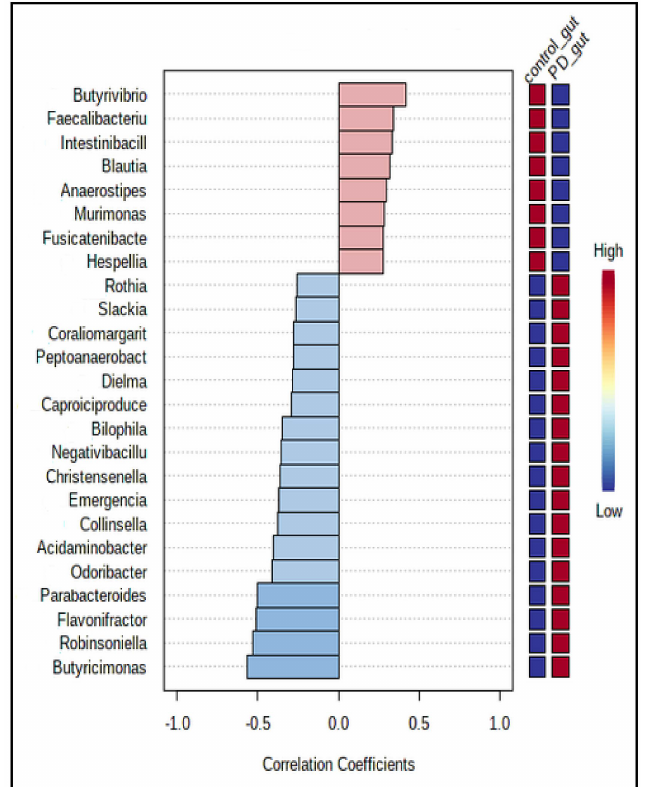
Figure 5. The Pearson r correlation, showing the top 25 features correlated with the taxa of interest. The 25 genera were ranked by their correlation. The blue color represents negative correlations, whereas the red color represents positive correlations. The deeper color (blue or red) means, the stronger correlation. The mini heatmap on the right side of the plot shows the high or low abundance in two